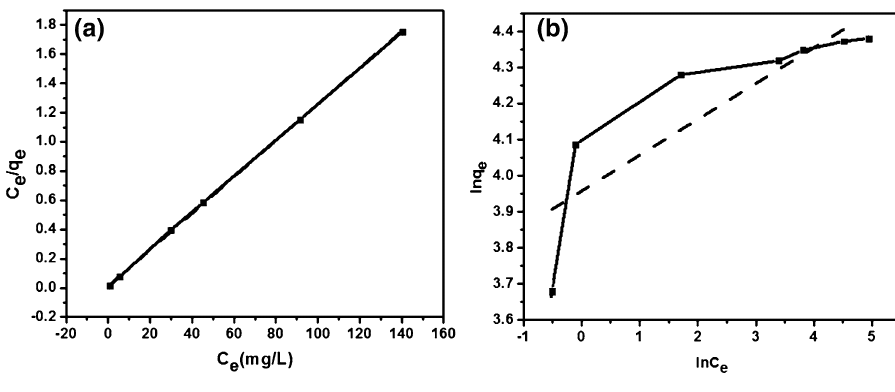
Fig. 8 a Langmuir and b Freundlich isotherms for the adsorption of AM onto AC-PEI